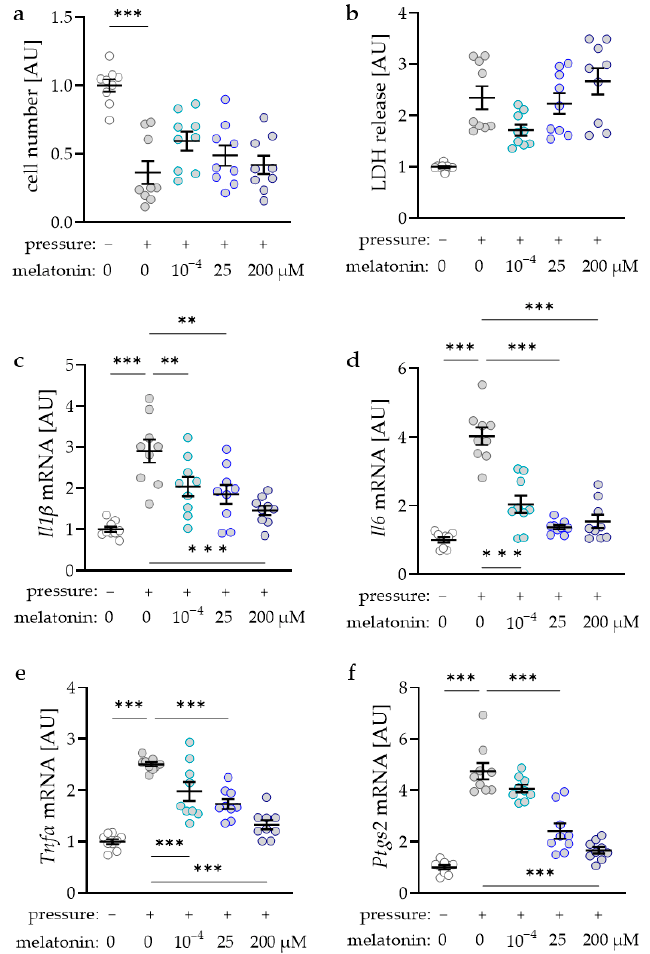
Figure 1. Impact of different melatonin concentrations in combination with compressive strain on cell number ( a ), lactate dehydrogenase (LDH) release ( b ) and gene expression of interleukin-1-beta (IL1 β , c ), IL6 ( d ), tumor necrosis factor alpha (TNF α , e ), or prostaglandin endoperoxide synthase-2 (PTGS2, f ); n = 9; Statistics: ordinary ANOVA with Holm – Šídák’s multiple comparison tests ( Il1 β , Il6 , and Tnf α ) or Welch-corrected ANOVA with Games – Howell multiple comparison tests (cell number, LDH release, Ptgs2 ); ** p < 0.01, *** p < 0.001.